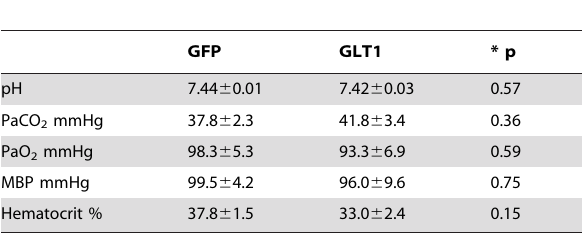
Table 1. GLT1 over-expression did not alter physiological parameters 30 min after MCAo.